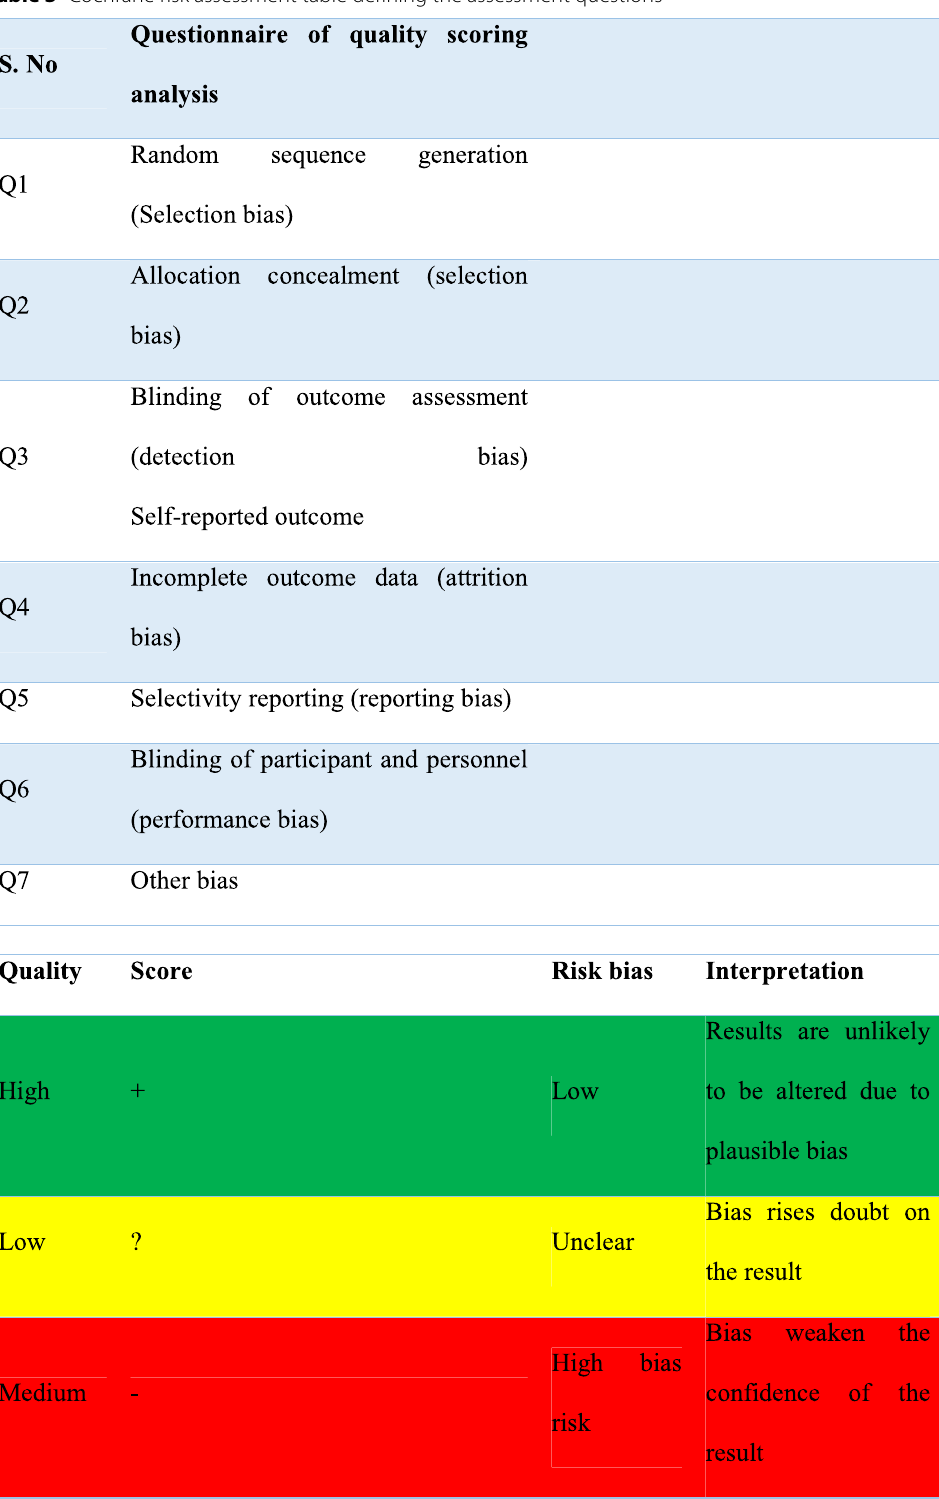
Table 3 Cochrane risk assessment table defining the assessment